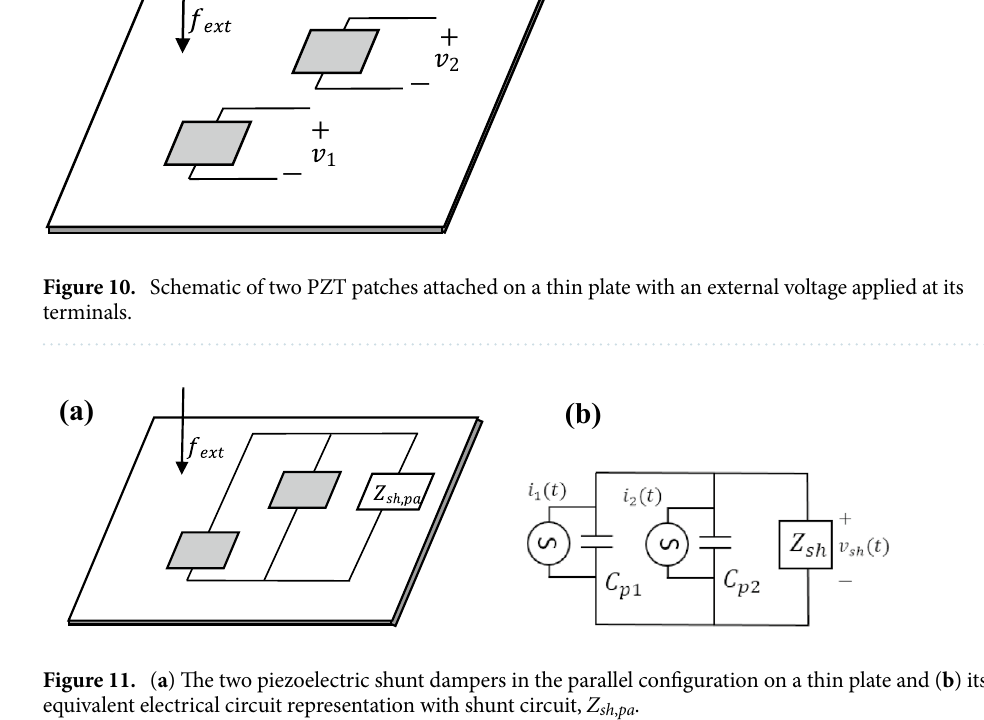
Figure 11. ( a ) The two piezoelectric shunt dampers in the parallel configuration on a thin plate and ( b ) its equivalent electrical circuit representation with shunt circuit, Z sh , pa